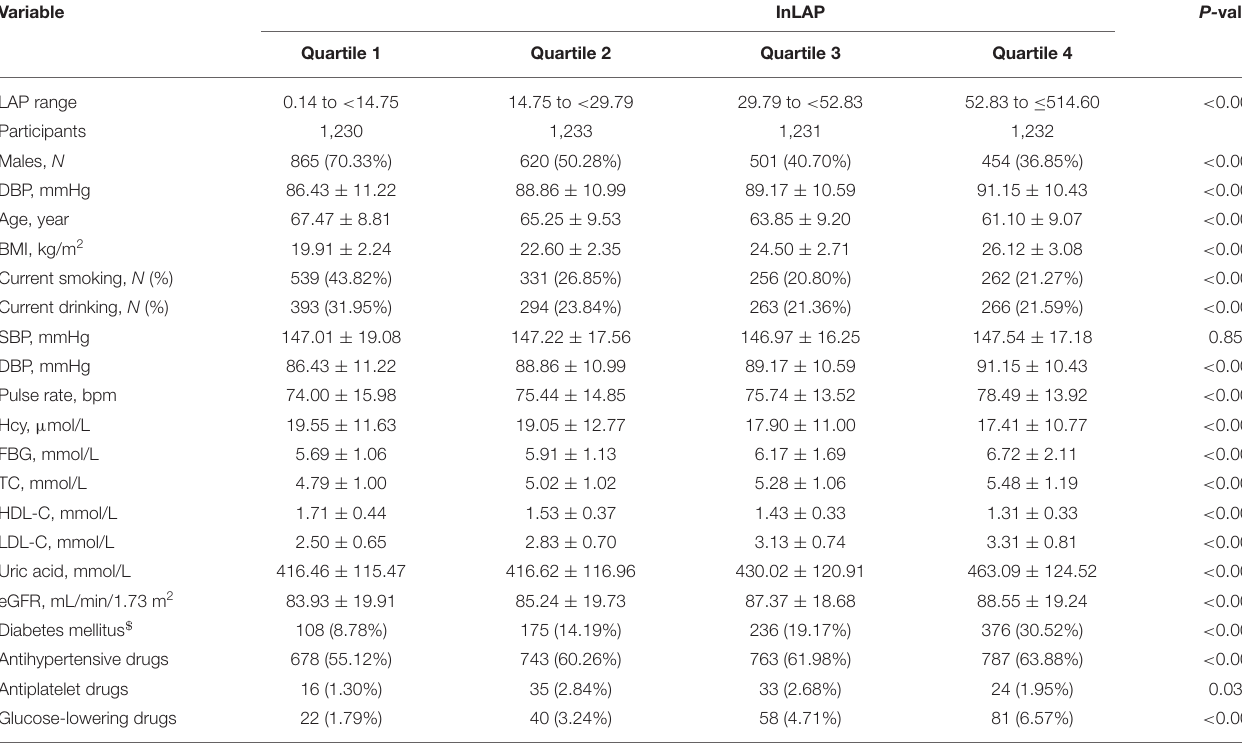
TABLE 1 | Clinical characteristics of the study population according to LAP. Variable